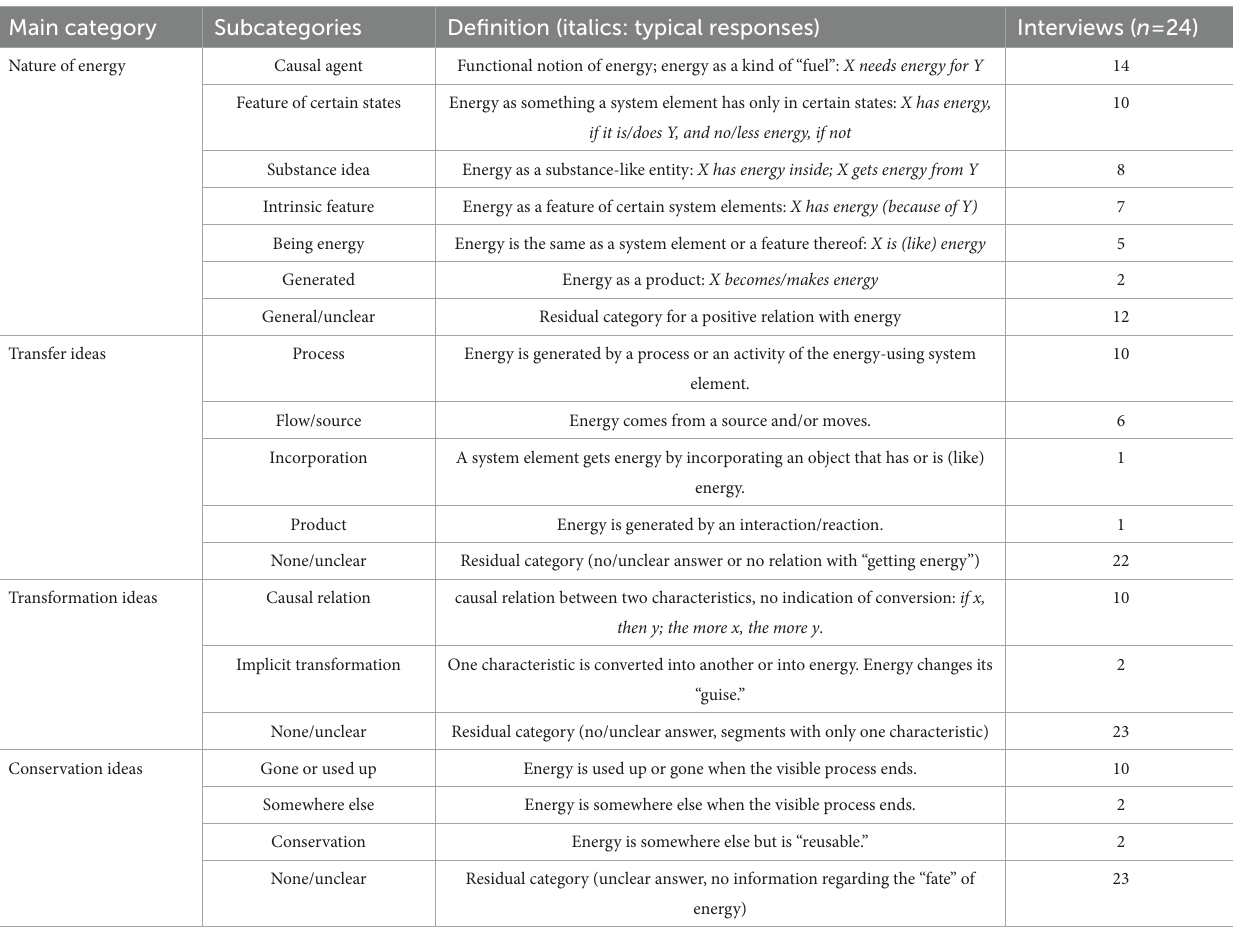
TABLE 4 Coding systems for the main categories nature of energy, transfer ideas, transformation ideas and conservation ideas, and frequencies of interviews with assigned subcategories. Main